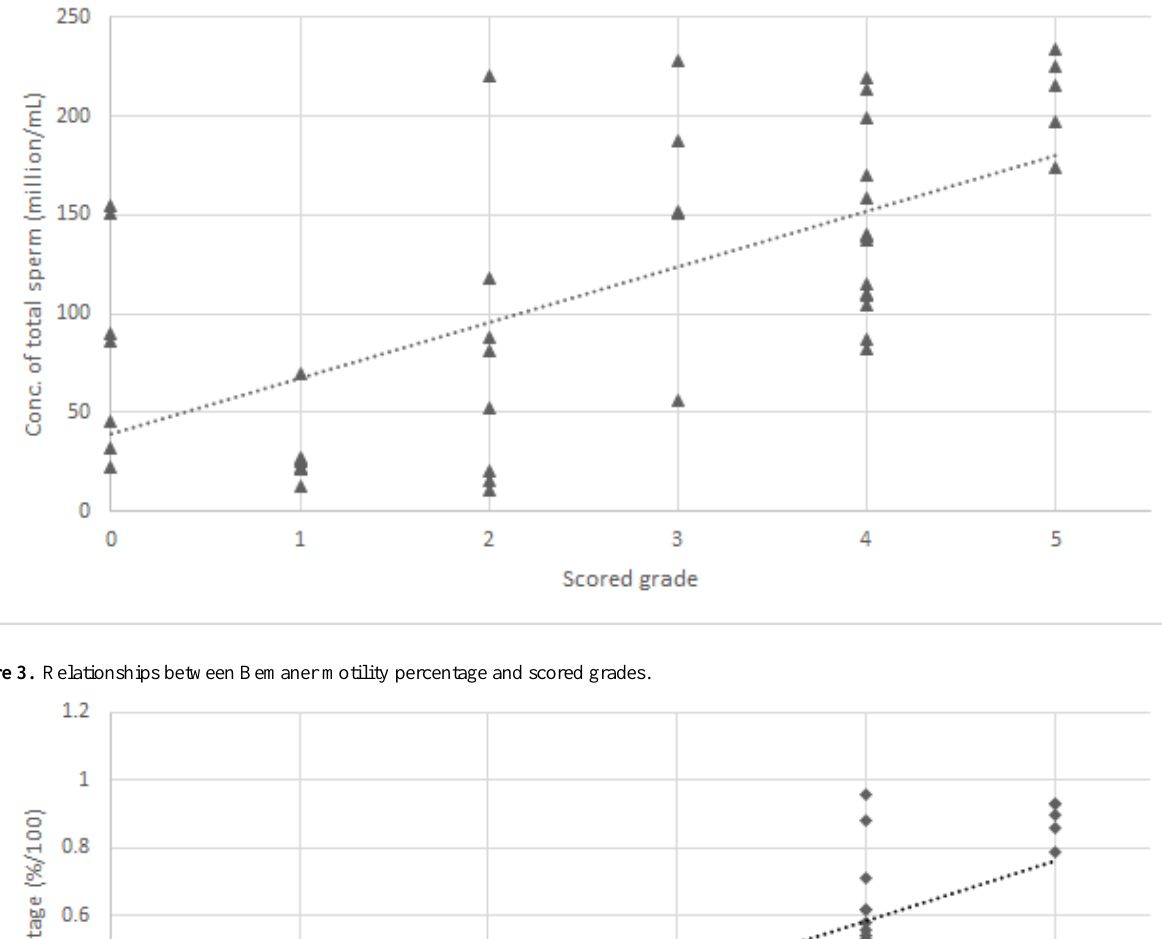
Figure 2. Relationship between Bemaner concentration of total sperm and scored grades.